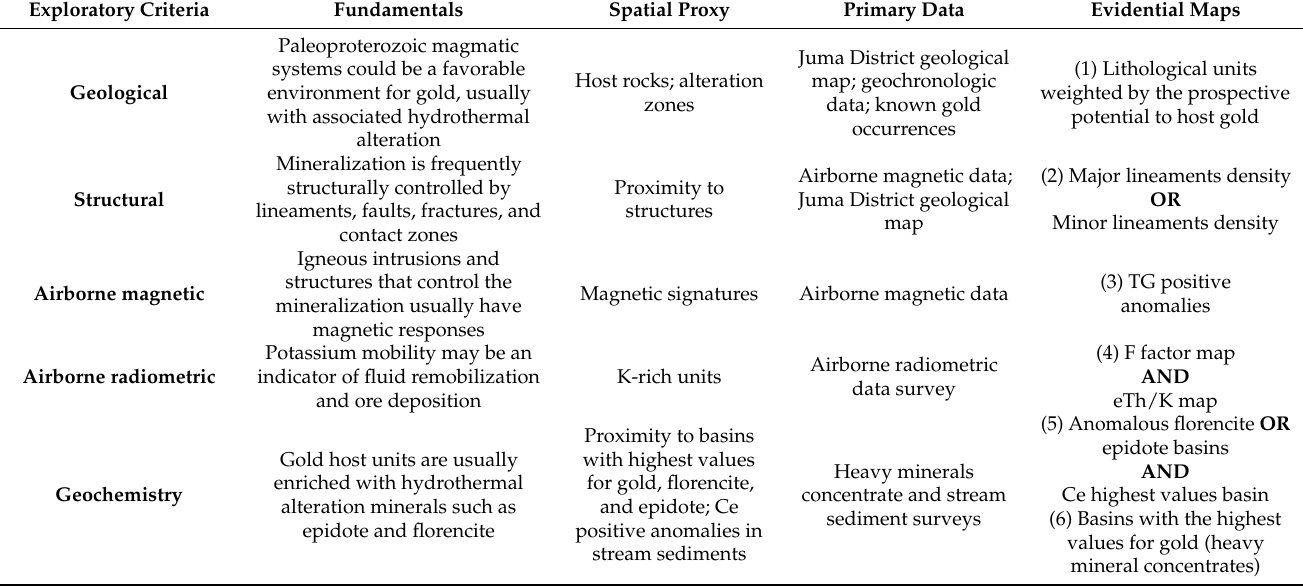
Table 3. Key characteristics describing the theoretical fundamentals, spatial proxies, primary data, and evidential maps in different exploratory criteria for the Guida